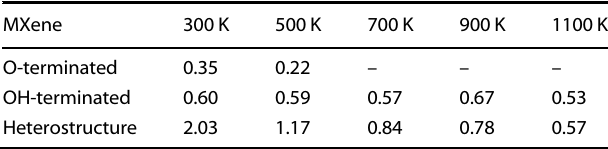
Table 1. Adhesive stress (in GPa) calculated from the intercept of linear fi ts to the data in Fig. 4.